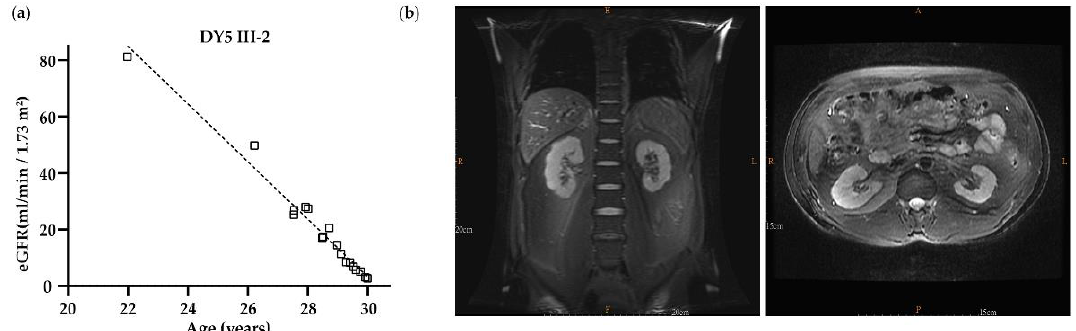
Figure 2. The clinical data from DY5 III-2. ( a ) Age versus estimated glomerular filtration rate (eGFR); the correlation between age and eGFR was analyzed by linear regression. The regression line was included, and eGFR was significantly decreased while aging. ( b ) MRI at the age of 29 showed that the contour of the bilateral kidneys was lobulated with some small cysts in the medullary pyramid, while the left kidney was smaller in size and thinner in the cortex compared to the right. Family CKD401 and WG: Two UMOD variants were identified in index individuals with gout or hyperuricemia before the age of 40. The UMOD variant c.817G > T (p.Val273Phe) was identified in individual CKD401; he presented with hyperuricemia and